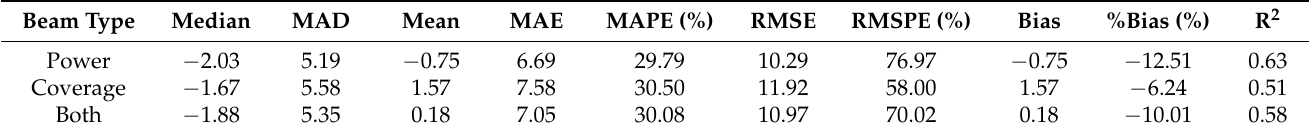
Table 3. Overall accuracy of GEDI canopy height estimates for all individual footprints (11,832). Statistics for differences in canopy height values (ALS 95 , GEDI 95 ). MAD is median absolute deviation, MAE is mean absolute error, MAPE is mean absolute percentage error, RMSE is root mean square error, RMSPE is RMS percentage error, and R 2 is the co-efficient of